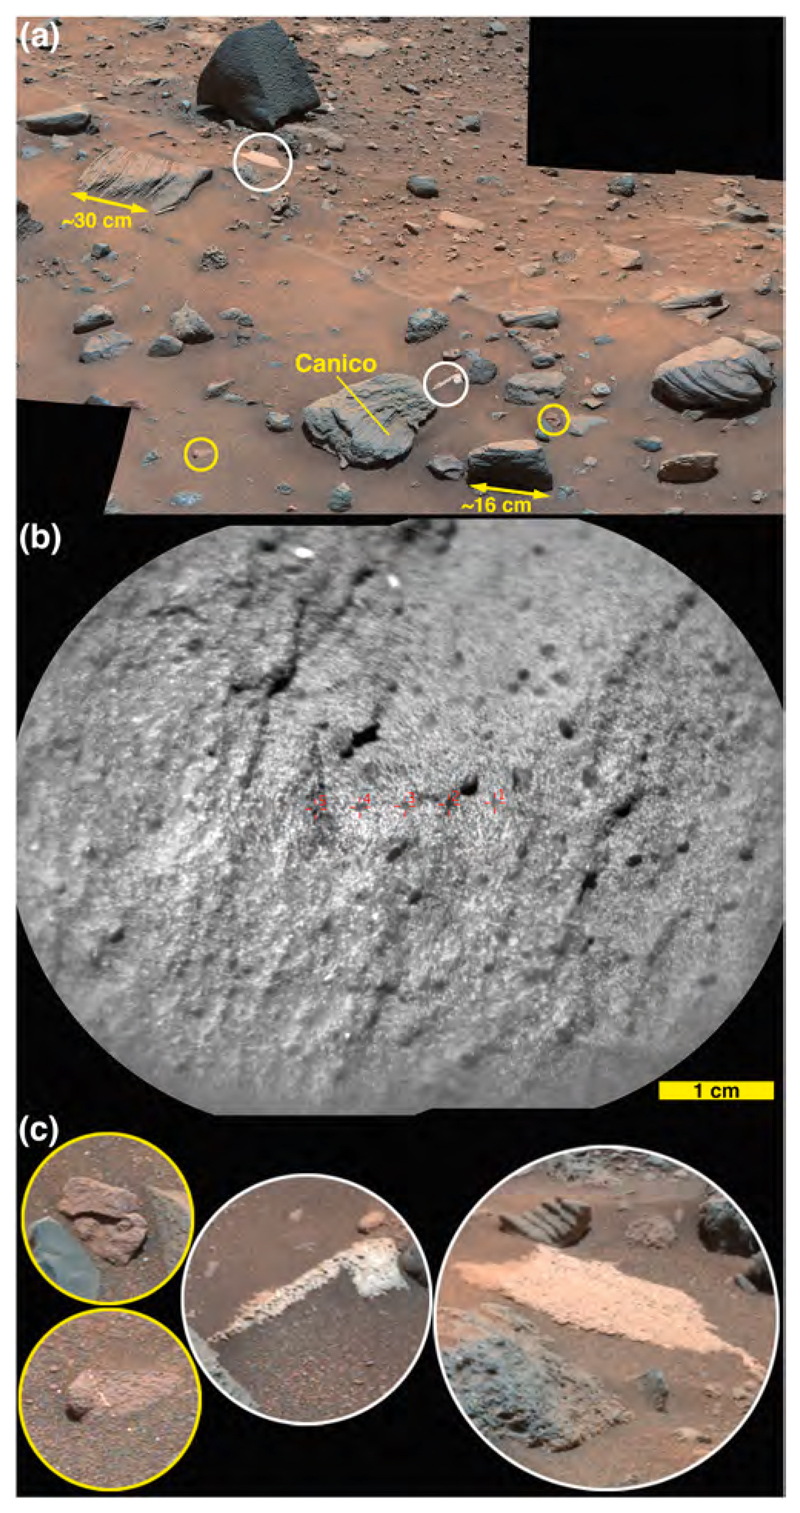
(a) Example showing diversity of cobble and boulder orientations, sedimentary structures, and colors at Bimbe. The white circles indicate examples of white stones shown in (c); the yellow circles indicate examples of “red” stones in (c). (b) Knobby sandstone target, Canico. (c) Examples of “red” (left) and white (center and right) cobbles which are minor constituents of the Bimbe deposit; locations and relative sizes are shown in (a). The red stone at the lower left in (c) has a white vein cutting across bedding within the stone. (For interpretation of the references to color in this figure, the reader is referred to the web version of this article.)